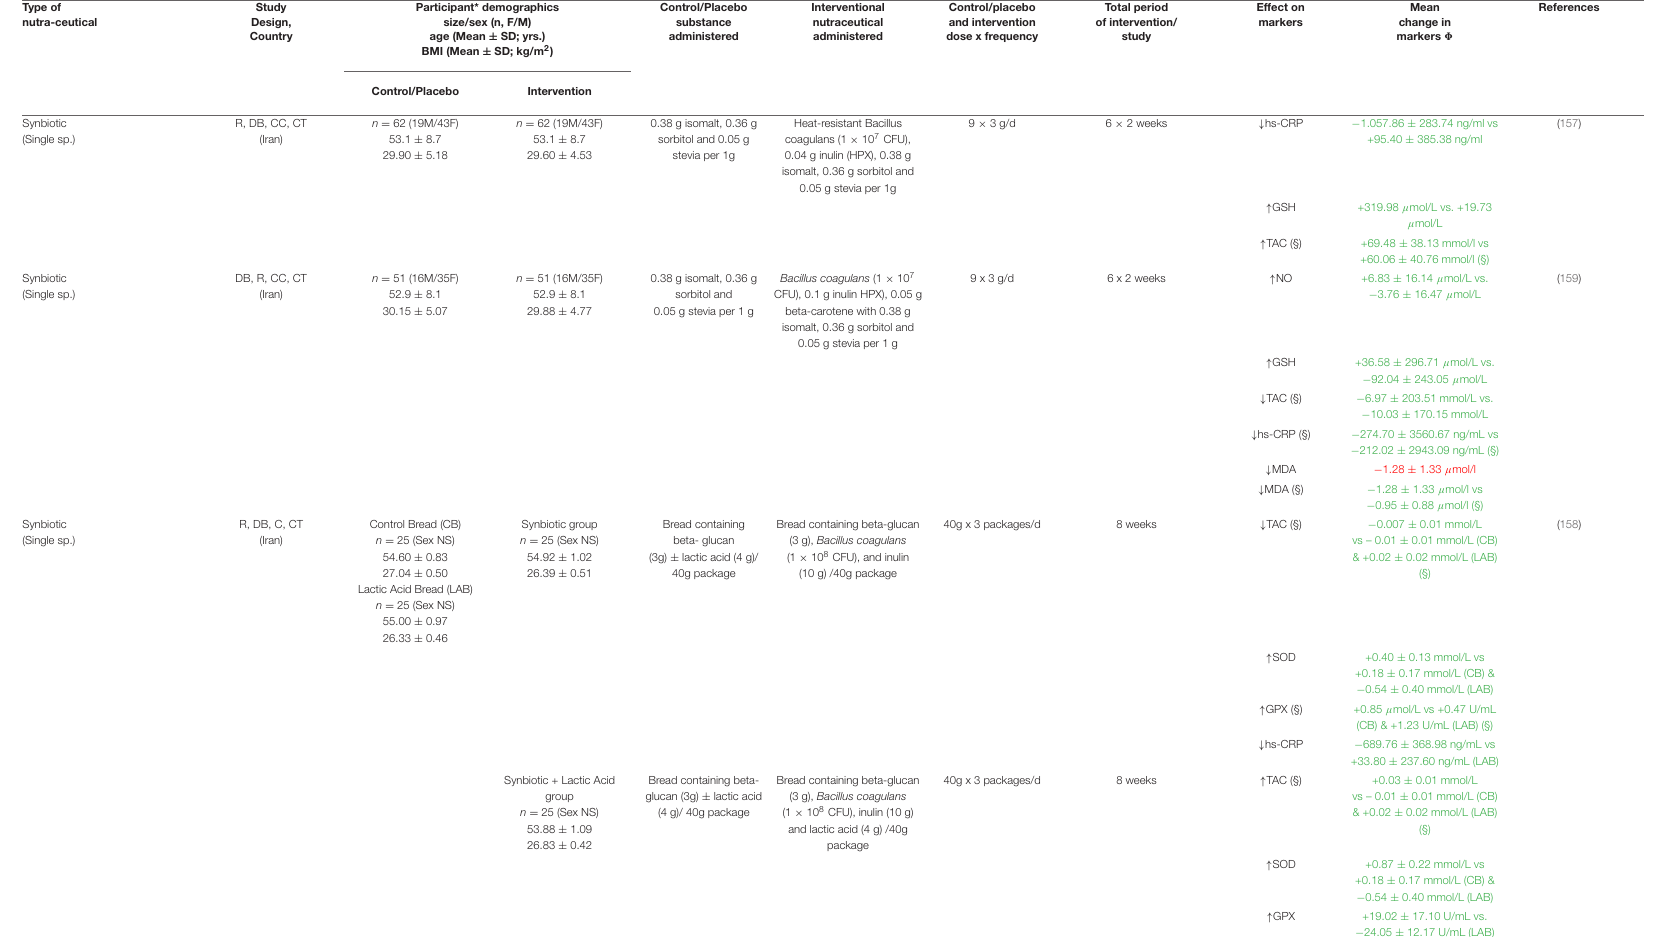
TABLE 4 | Studies investigating the effects of synbiotics on markers of inflammation and oxidative stress. Typeof